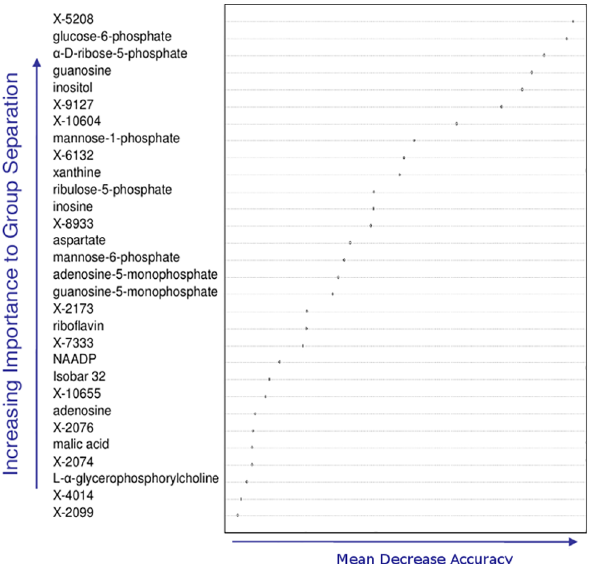
Fig 4. Liver metabolites key to group separation predicted by Random Forest classification. The top 30 liver metabolites important for increasing class separation as determined by the Random Forest approach. Key among these are metabolites representing pentose cycle and related glycolytic metabolites (glucose- 6-P, mannose-6P, mannose-1P, ribose-5-P, ribulose-5-P) and purine metabolism (inosine, guanosine, adenosine, xanthine, adenosine-5-P, guanosine-5-P) (see text).